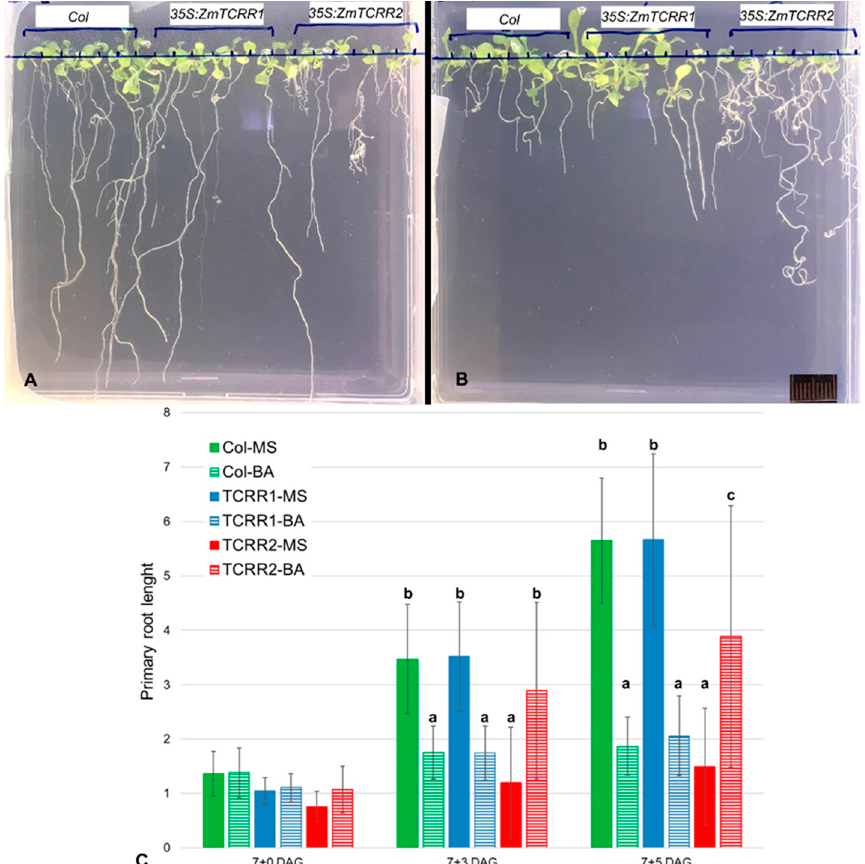
Figure 4. ZmTCRR2, but no ZmTCRR1, interferes with cytokinin signalling. Seven-day-old primary transgenic plants were extracted from the herbicide selection plates and cultured vertically with MS media containing no hormone or 5 µM BA. Upper panel, a representative set of plates, 7 days after culture. ( A ), no hormone; ( B ), 5 µM BA. The rule in ( B ) is 1 cm. ( C ), average primary root length (in cm) of each genotype in each culture media, after 0, 3, or 5 days in the vertical plates. The error bars represent the standard deviation. The graph shows a strong interaction between genotypes and treatments. After 3 days of culture, ZmTCRR2 plants in the presence of 5 µM BA are in a statistically homogeneous group with WT (Col) and ZmTCRR1 plants in the absence of hormone; this group is statistically distinct ( p < 0.05) from that formed by WT and ZmTCRR1 plants in the presence of the hormone. Letters on the columns identify statistically homogeneous classes according to pairwise comparisons (Bonferroni test, 95% confidence).